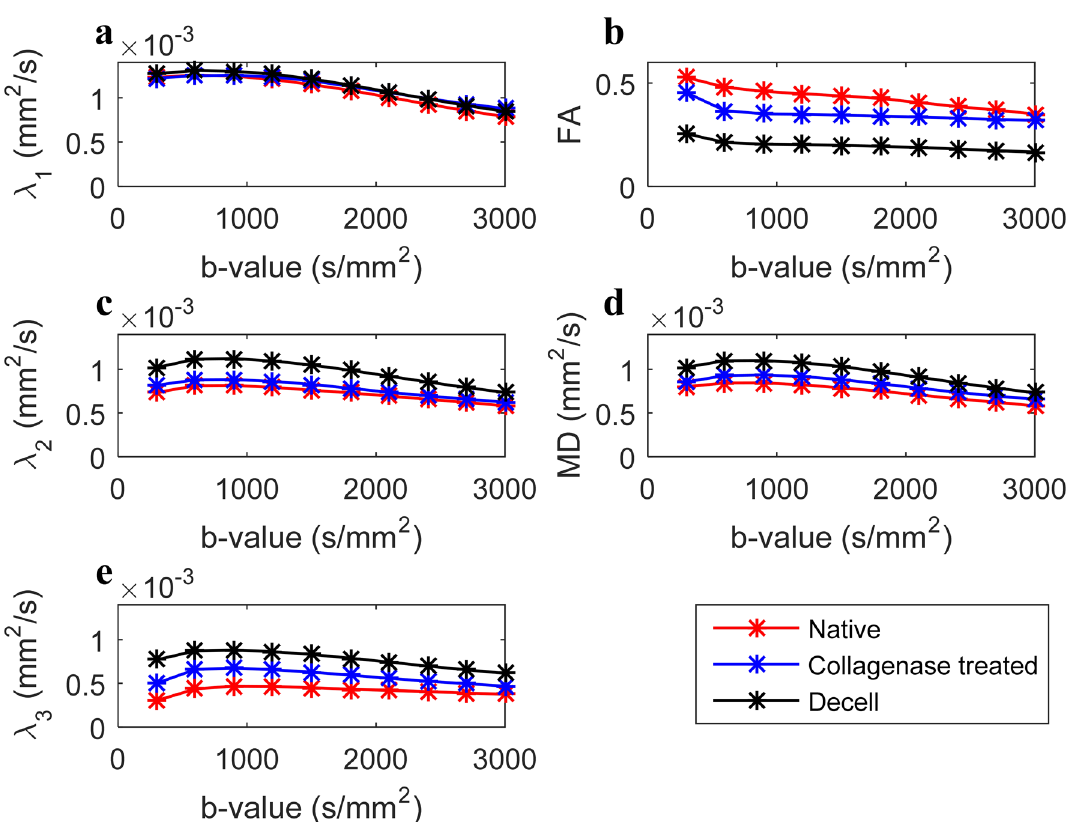
Figure 4. Effect of change in b-value by gradient strength on calculated eigenvalues ( a , c , e ), fractional anisotropy ( b ) and mean diffusivity ( d ). The analysis was carried out using HMb